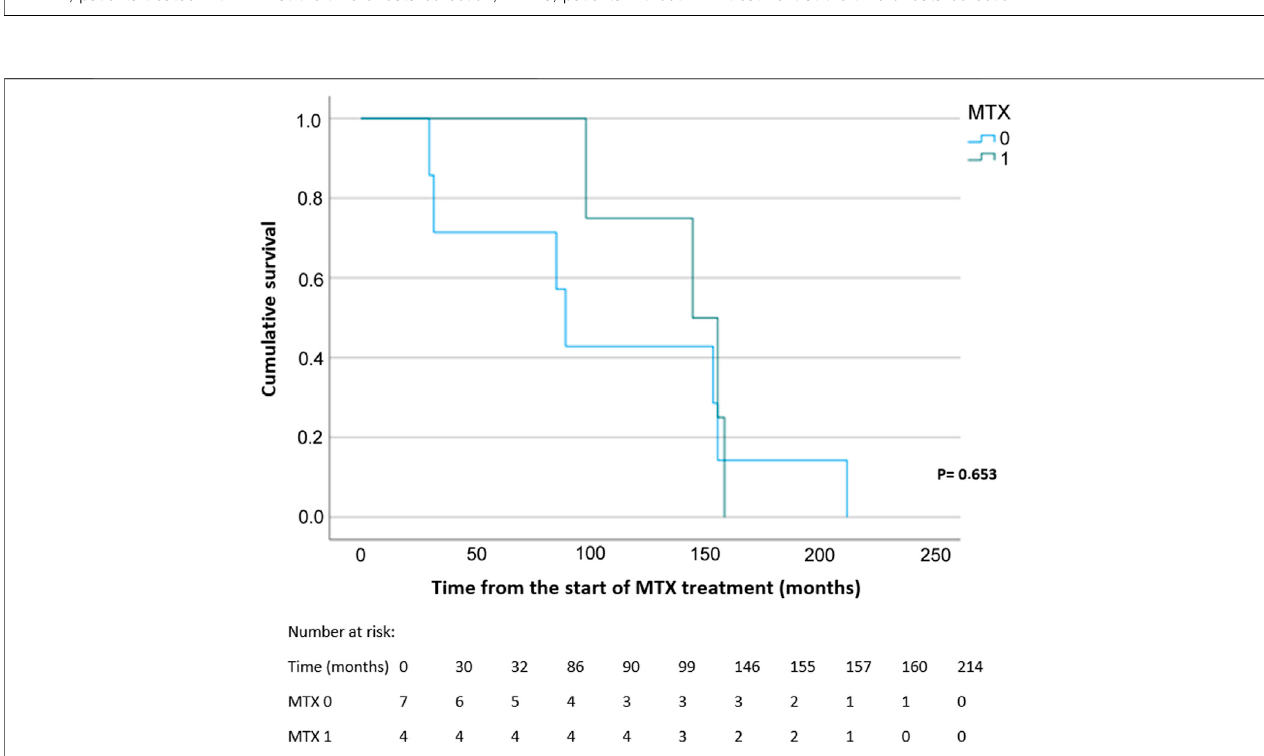
FIGURE 3 | Kaplan – Meier curve and survival analysis for all-cause mortality probability using the log-rank test. MTX, methotrexate; MTX 1, patients treated with MTX at the time of data collection; MTX 0, patients without MTX treatment at the time of data collection.